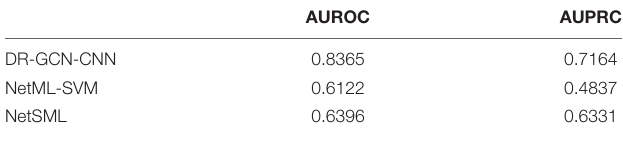
TABLE 2 | Comparison of prediction models on pan-cancer